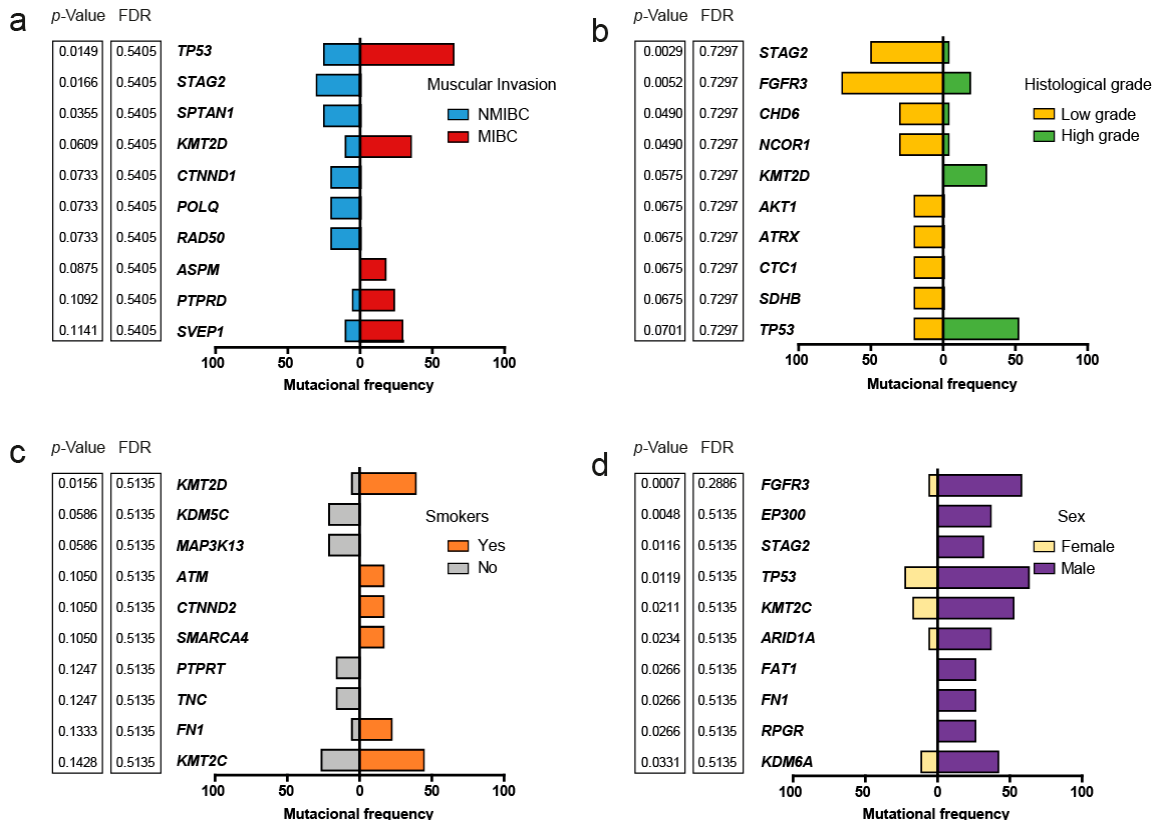
Figure 4. Muscle invasion, histologic grade, smoking status, sex, and the frequency of somatic variants. The 10 most affected genes were ordered in ascending order according to smallest p -value on the top, obtained with the Fisher’s exact test; ( a ) Comparison of somatic variant frequency according to the muscular invasion phenotype; ( b ) Comparison of somatic variant frequency according to the histologic grade; ( c ) Comparison of somatic variant frequency according to the smoking status; ( d ) Comparison of somatic variant frequency according to the sex of the patients.